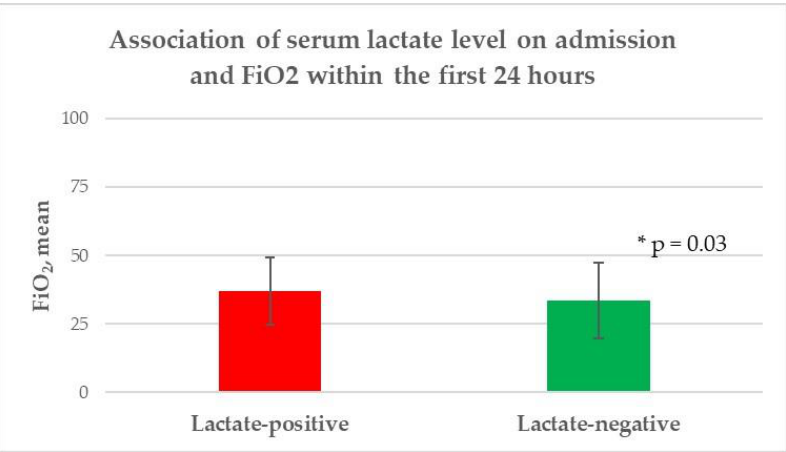
Figure 3. Association of the serum lactate level upon admission and FiO2 within the first 24 h . FiO 2 : inspiratory oxygen fraction , * level of significance.